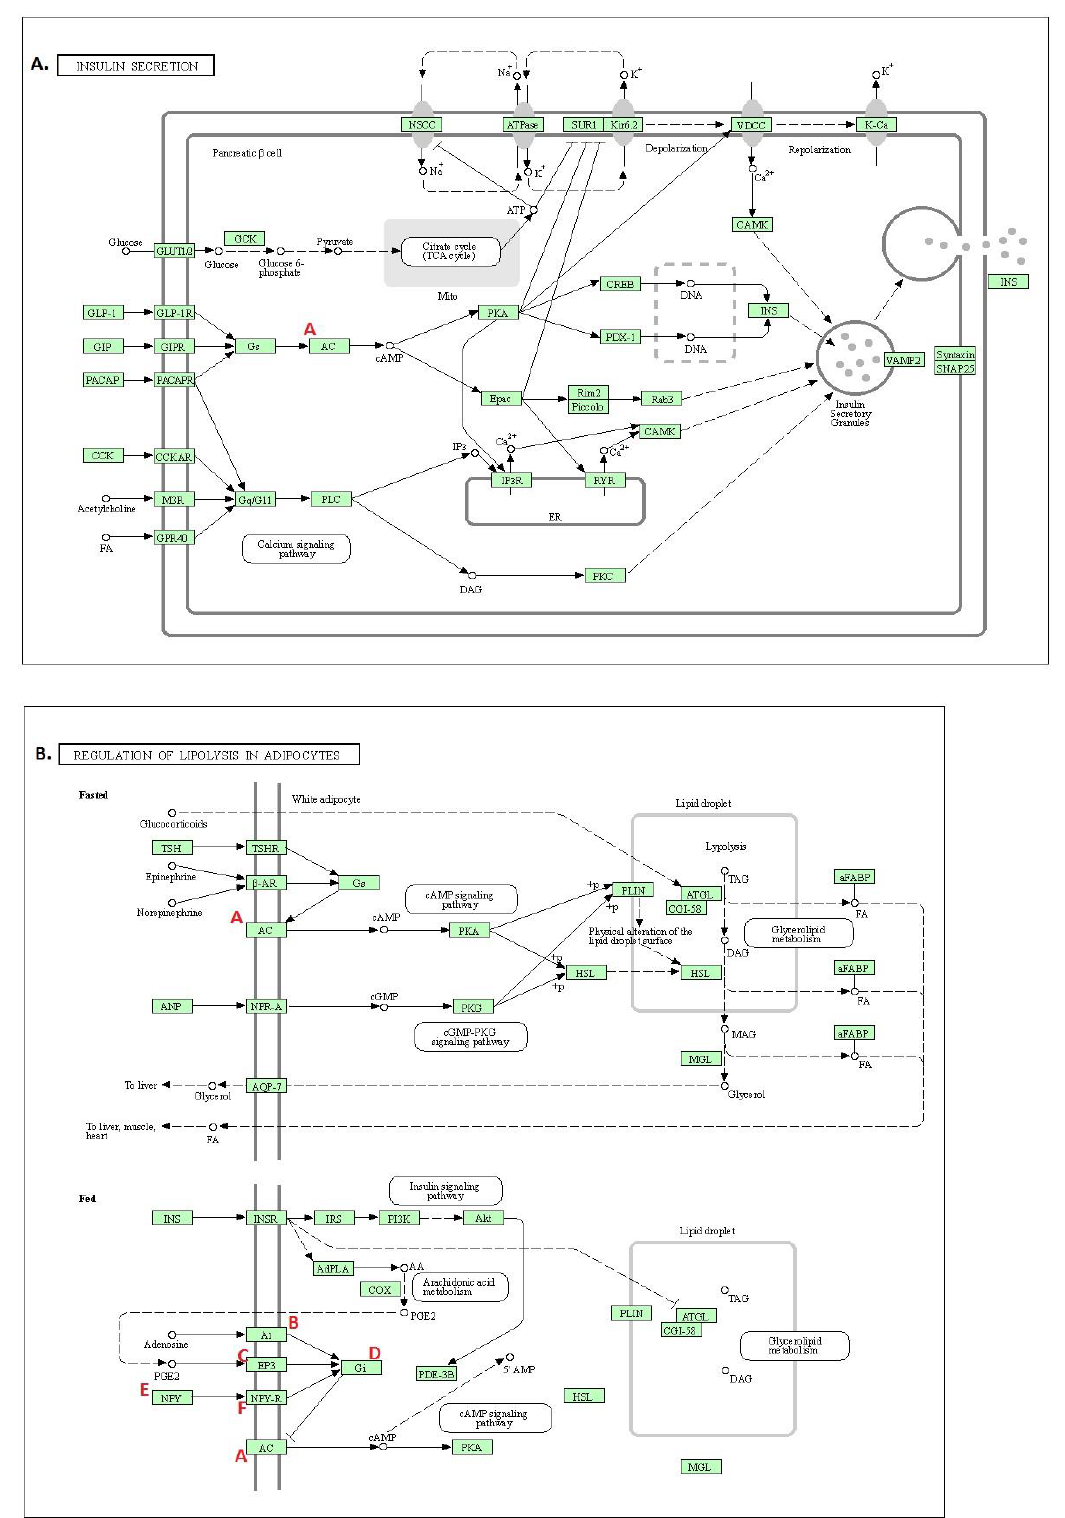
Figure 11. Involvement of target proteins in ( A ) insulin secretion and ( B ) regulation of lipolysis in adipocytes. A = ADCY1, ADCY3, ADCY4, ADCY5, ADCY6, ADCY7, ADCY8, and ADCY9; B = ADORA1; C = PTGER3; D = GNAI1, GNAI2, and GNAI3; E=NPY; F=NPY1R.